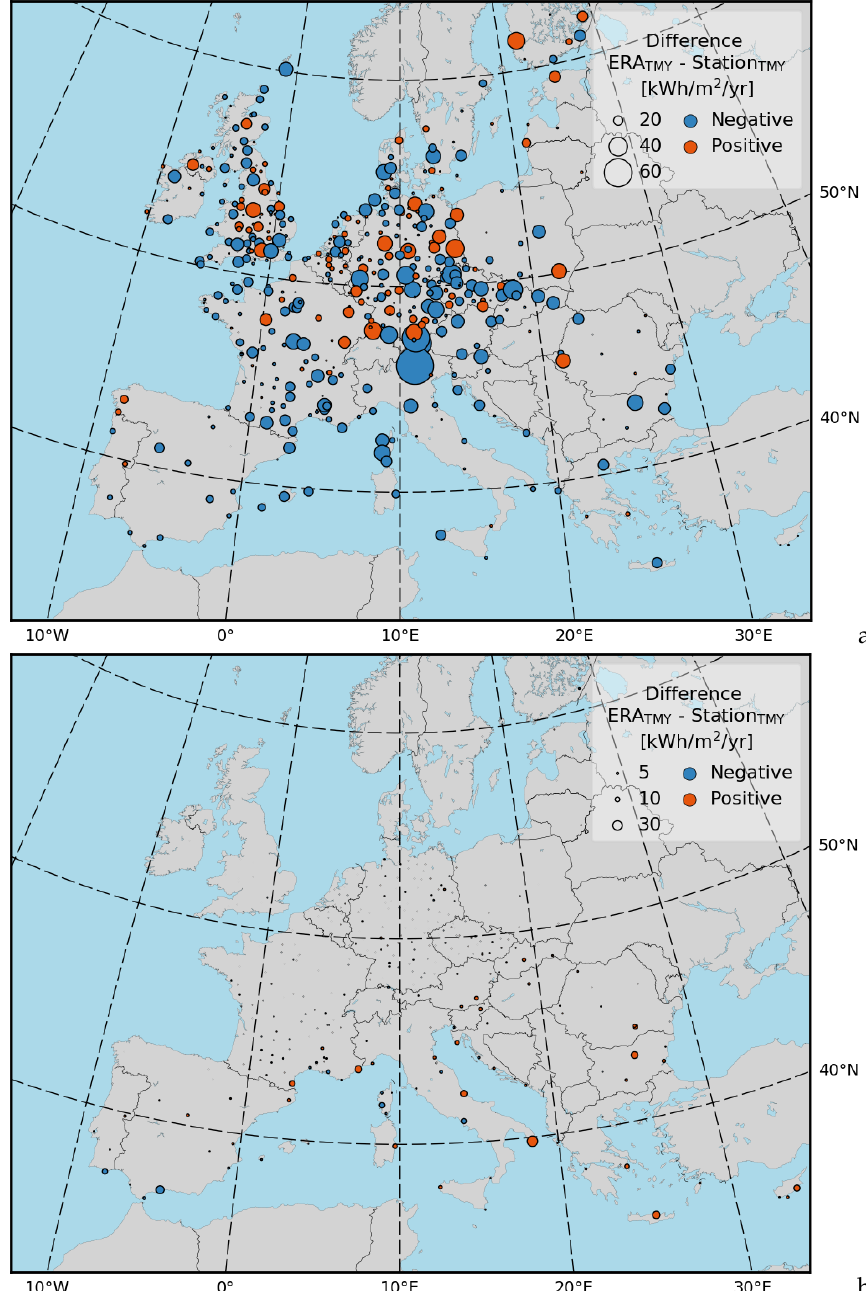
Figure 10. Map showing difference in EnergyPlus energy consumption calculation when using the ERA-based TMY data and the station-based TMY data for an office building. ( a ) heating energy consumption; ( b ) cooling energy consumption.Values are shown in kWh/m 2 difference, with the size of the marker indicating the magnitude of the